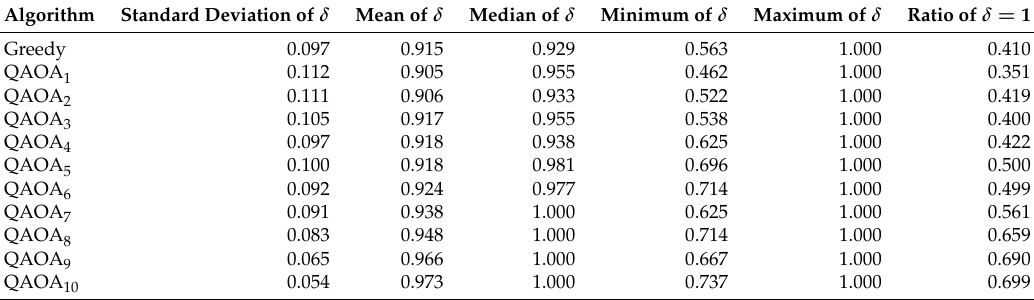
Table A2. Simulation data for the 5-regular weighted